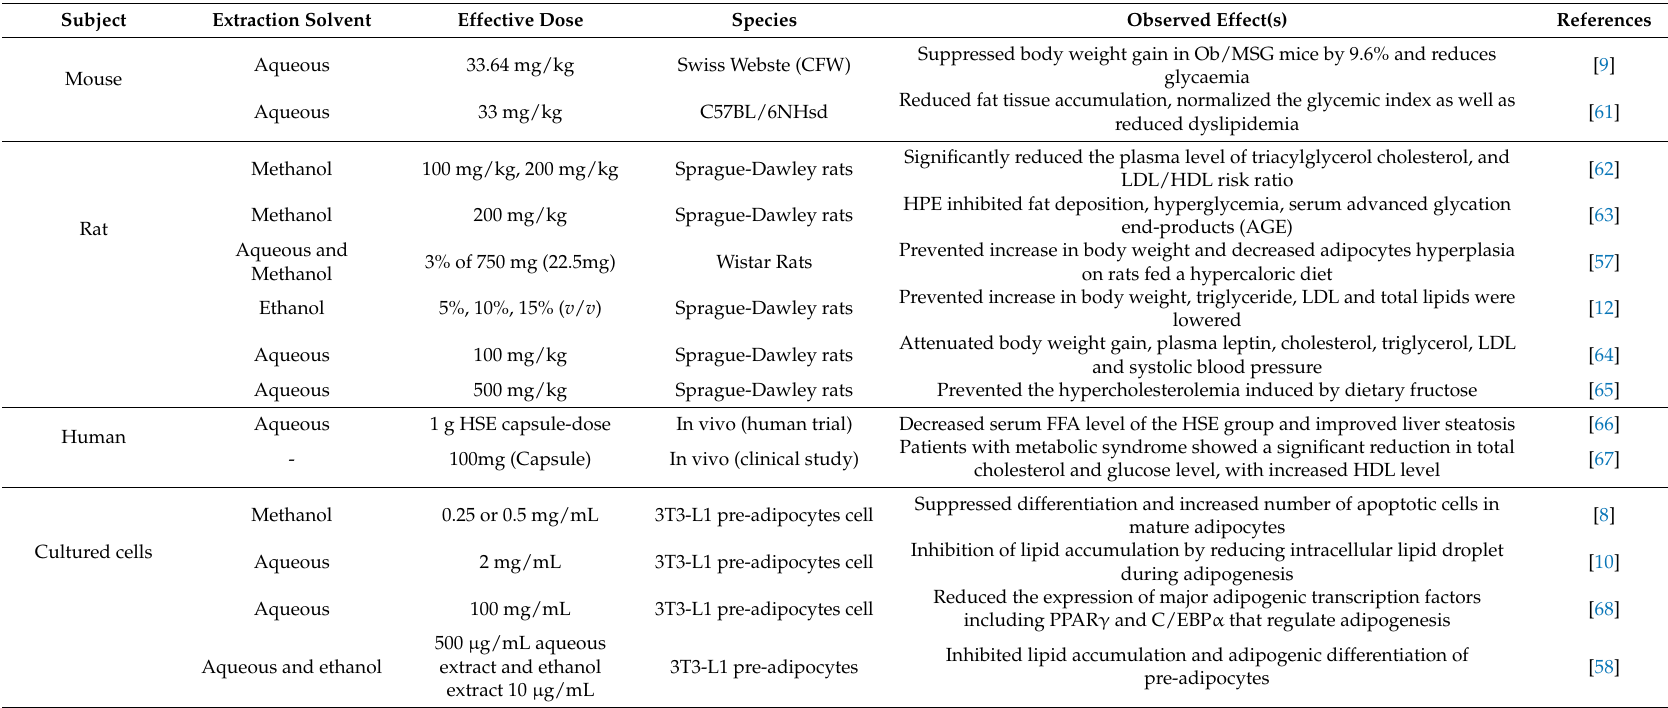
Table 2. Studies on H. sabdariffa bioactive compounds and their anti-obesity